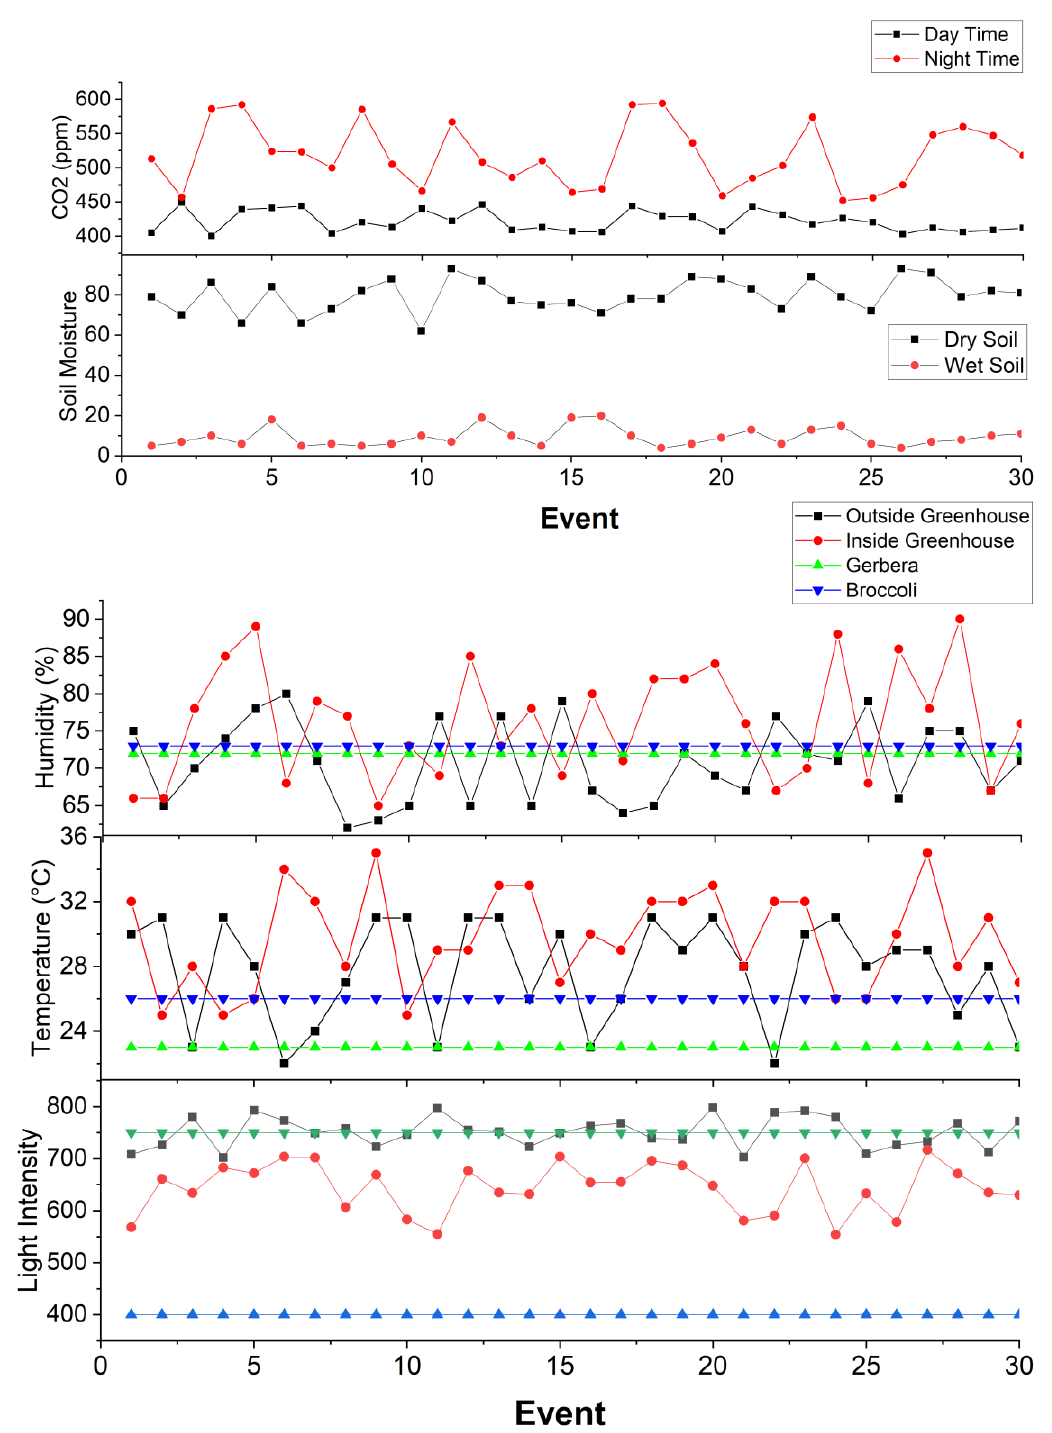
Figure 11. Sensor parameter representation relative to outside and inside the greenhouse for two crops, Gerbera and Broccoli.